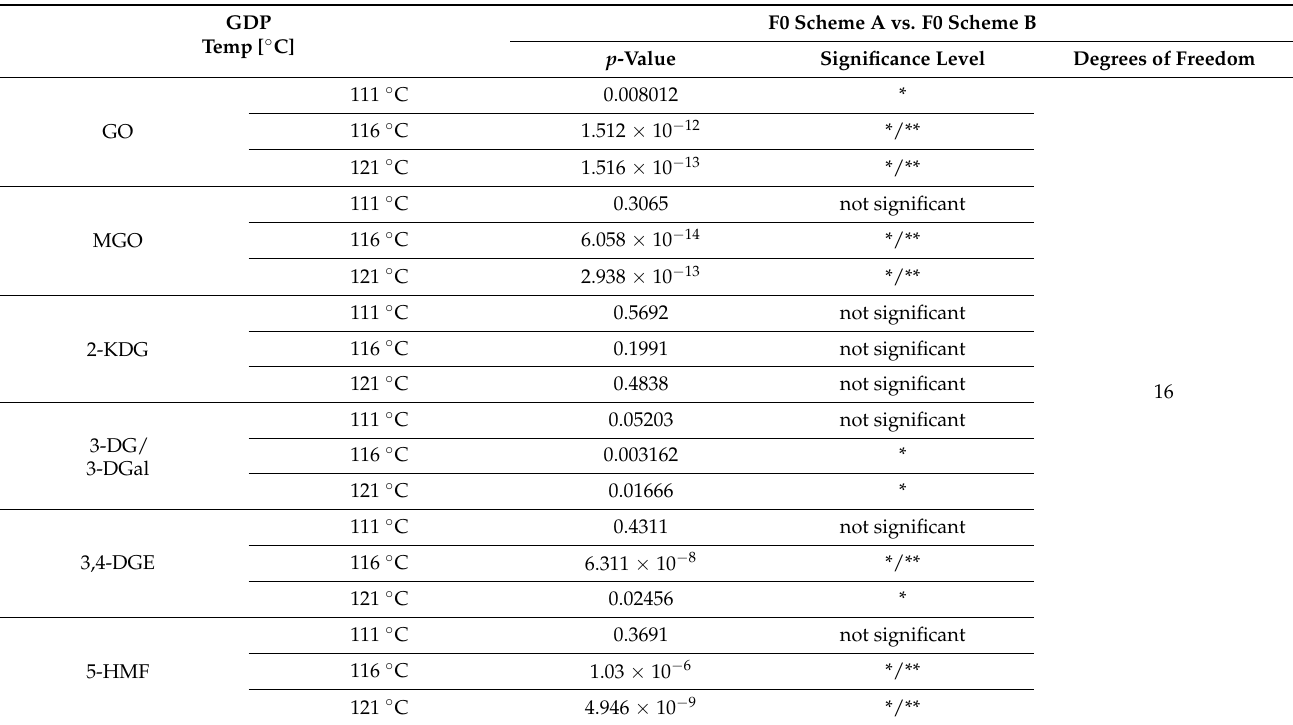
Table 12. Comparison of the two autoclaving schemes A and B with regard to the influence of temperature on the resulting GDP